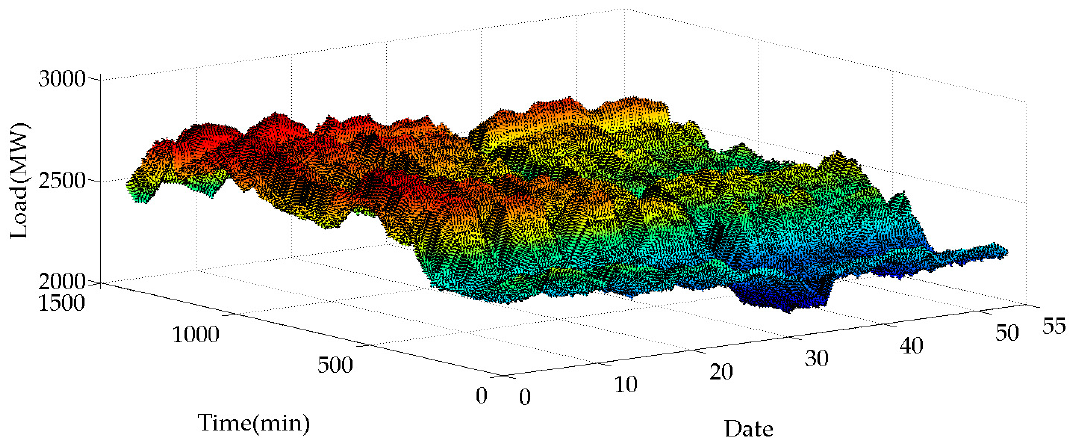
Figure 1. Actual load curve of one province from 3 March to 24 April.